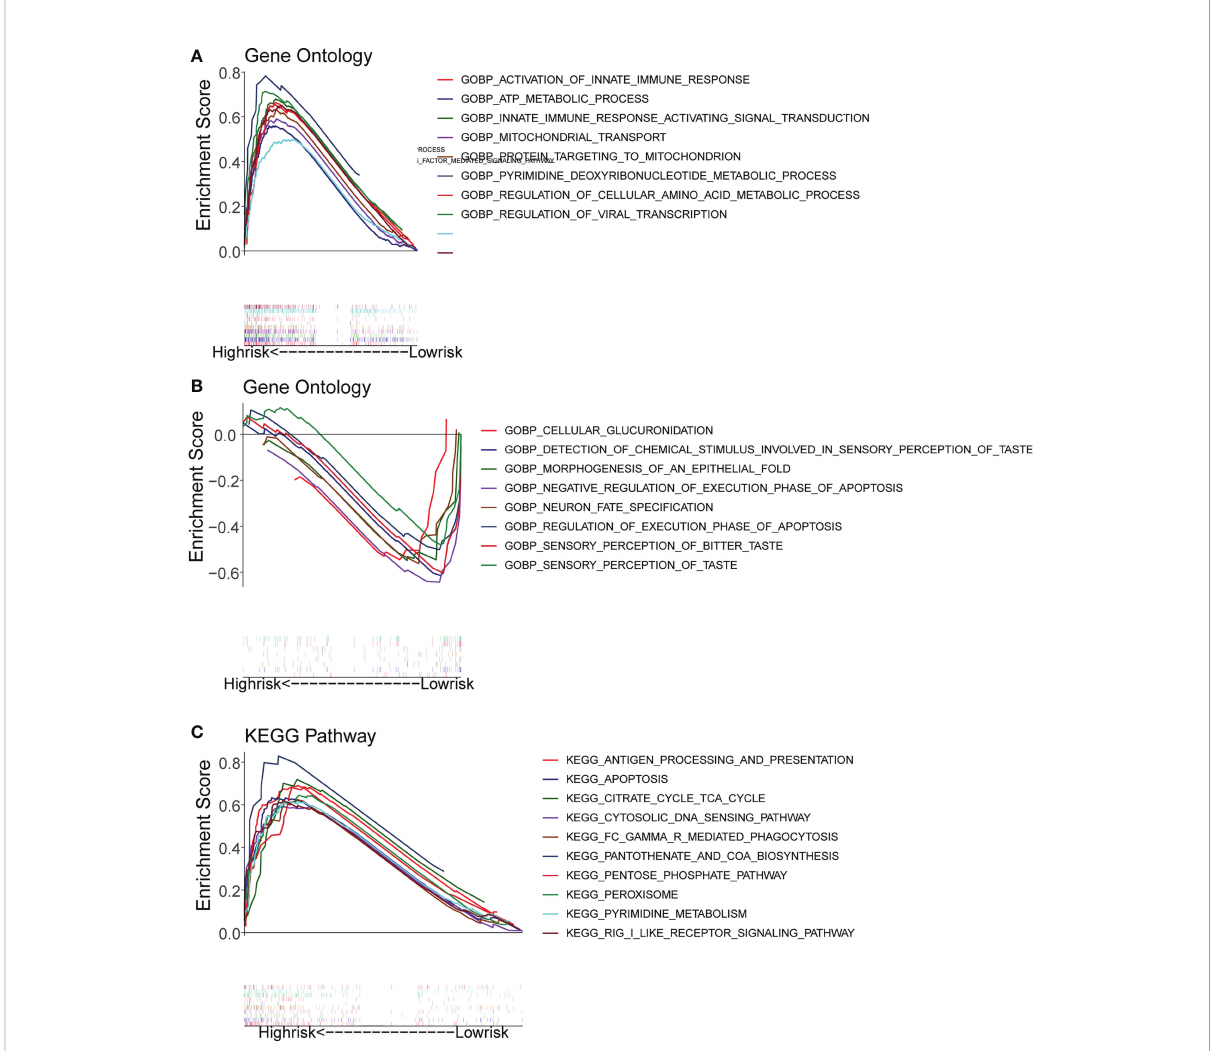
FIGURE 6 Gene Set Enrichment Analysis (GSEA) for the high- and low-risk groups. (A, B) GO enrichment analysis. (C) KEGG pathway